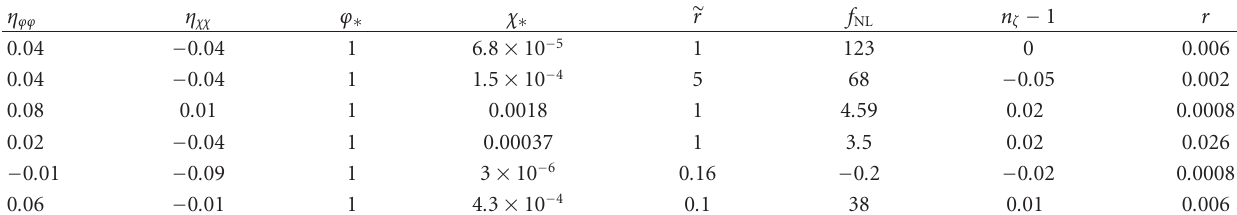
Table 2: Same as Table 1, but with di ff erent end condition, g 2 1 = g 2 2 as used in Section